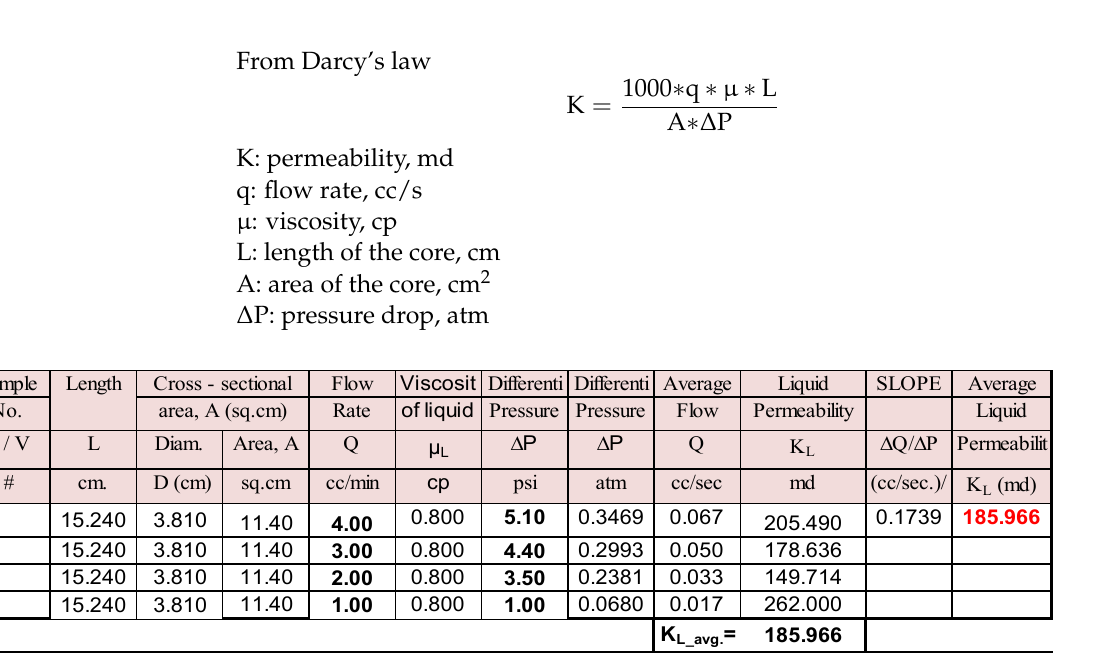
Figure A1. Permeability calculations.